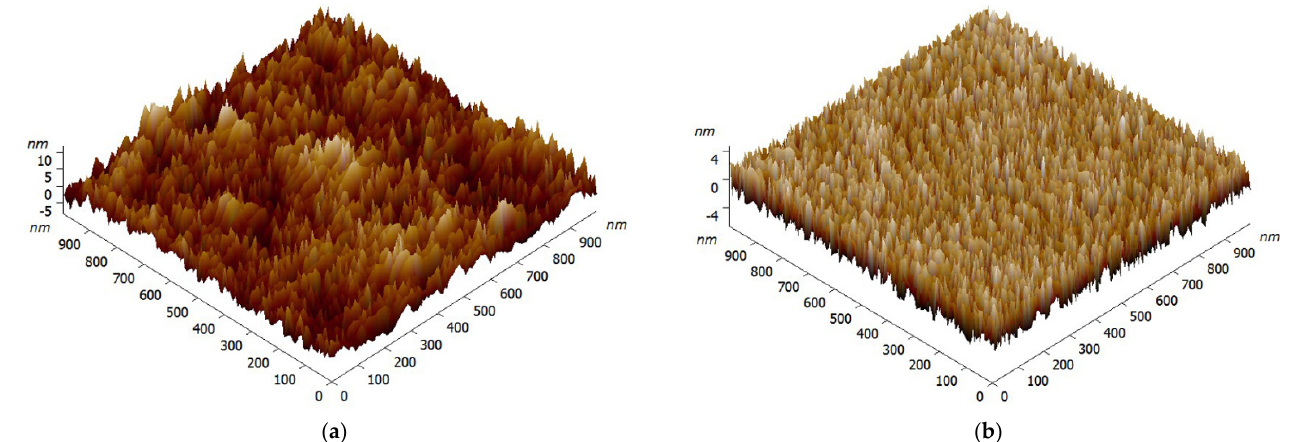
Figure 1. AFM images (1 μ m×1 μ m) of the glass substrate ( a ) and PVP film ( b